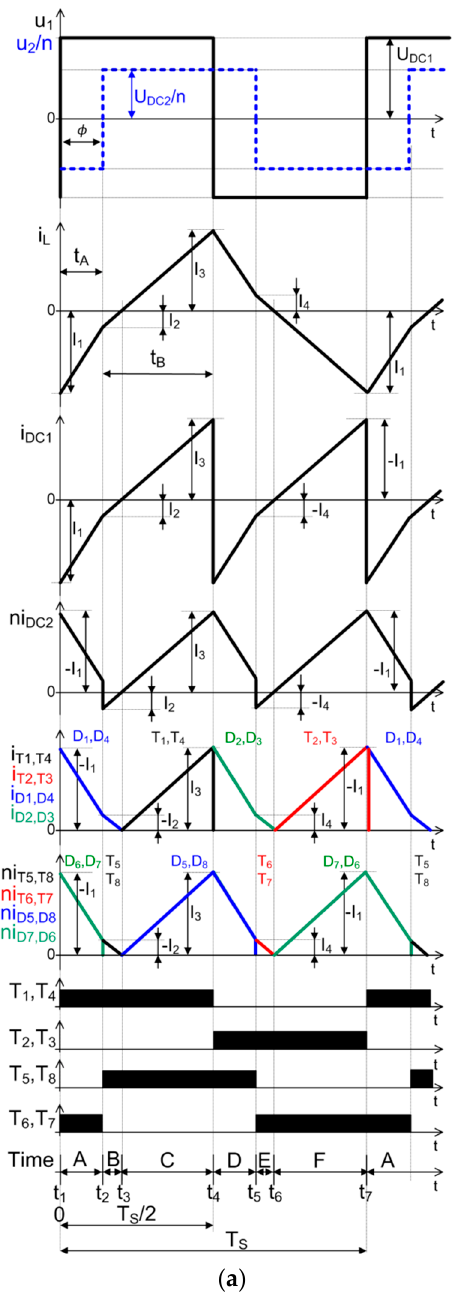
Figure 3. Simplified voltage and current waveforms of DAB converter for U DC 1 > U DC 2 / n : ( a ) with I 2 < 0; ( b ) with I 2 > 0. I 2 < 0; ( b ) with I 2 >